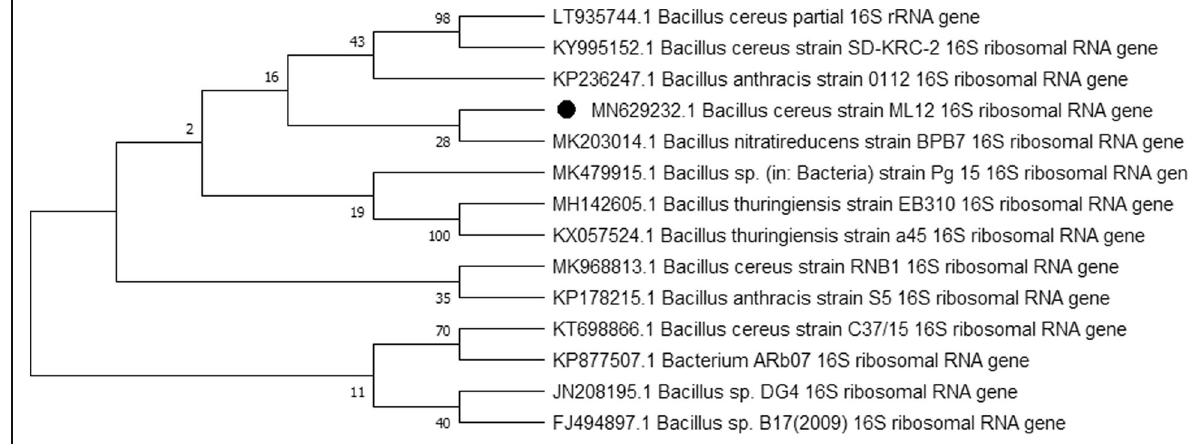
Fig. 6 The phylogenetic tree was constructed based on 16S rRNA gene sequences of Bacillus cereus (ML12) with other Bacillus species obtained from the GenBank